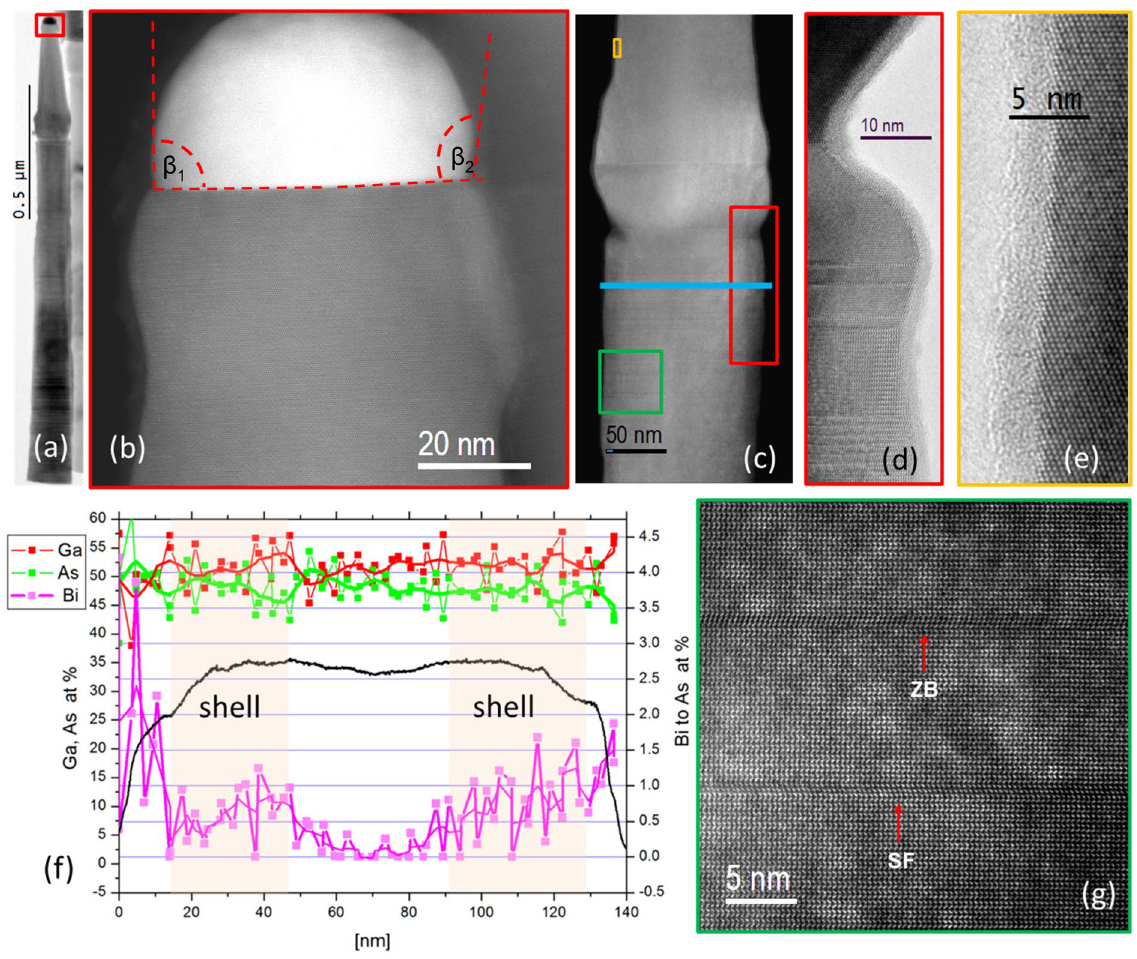
Figure 2. ( a ) TEM image of a GaAs-GaAs 0.99 Bi 0.01 core–shell nanowire (sample 1), conical tip results from the residual axial growth during Ga(As,Bi) shell deposition; ( b ) ADF-STEM image of the upper zinc-blende stacking fault free part of NW below gold catalyzer droplet; ( c ) STEM image of the transition part of the NW between GaAs core and the section which grows during Ga(As,Bi) shell deposition; ( d ) HRTEM image showing progressive transition from WZ to pure ZB structure of the top NW part displayed in ( e )—marked as small yellow rectangle in ( c ); ( f ) EDS elemental distribution profile for As, Bi and Ga along the blue line together with the STEM intensity; ( g ) typical structure of the bottom part of the NW bellow the transition zone evidencing mainly WZ structure, the single SF and the 3 ML thick ZB inclusion are also